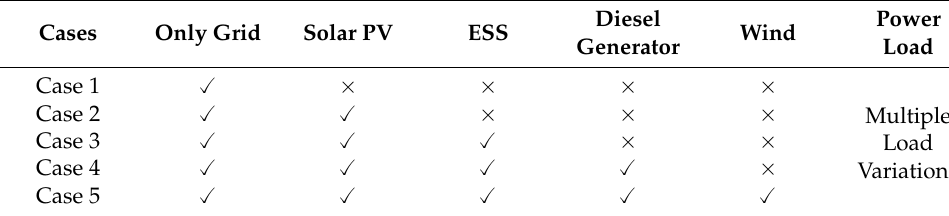
Table 3. Electricity prices in peak and off-peak times.